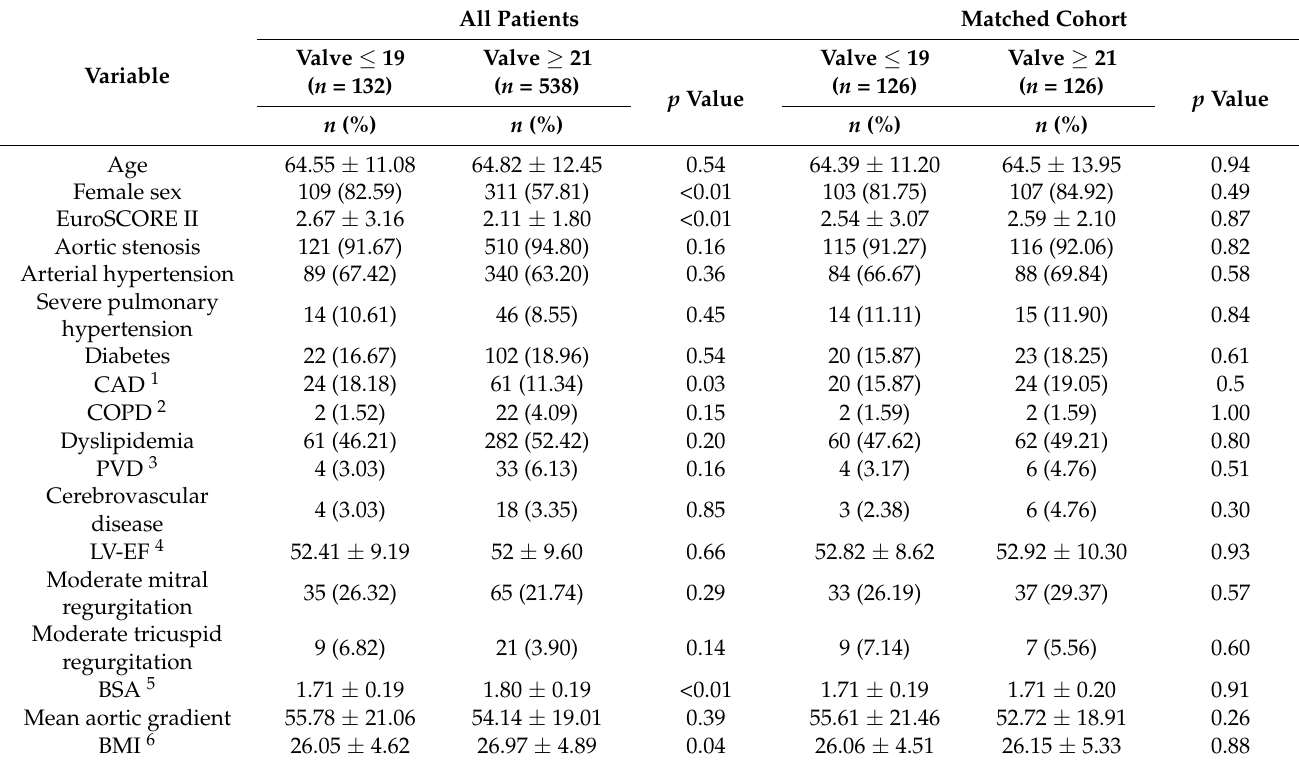
Figure 1. Bias before and after propensity matching. Table 1 Baseline characteristics of the study cohort.